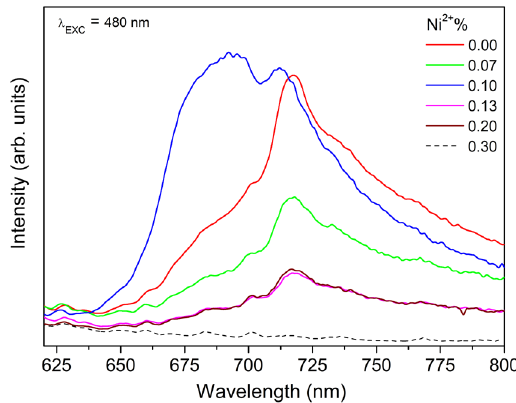
Ni TiO , 2(1-x) 2x 4